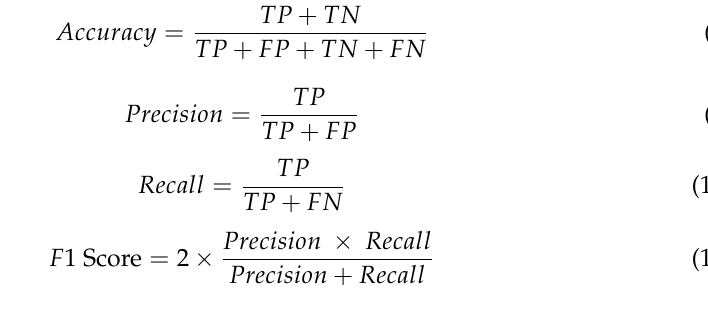
Table 3. Confusion Matrix for six Neural Network Models. Accuracy Precision Recall F1